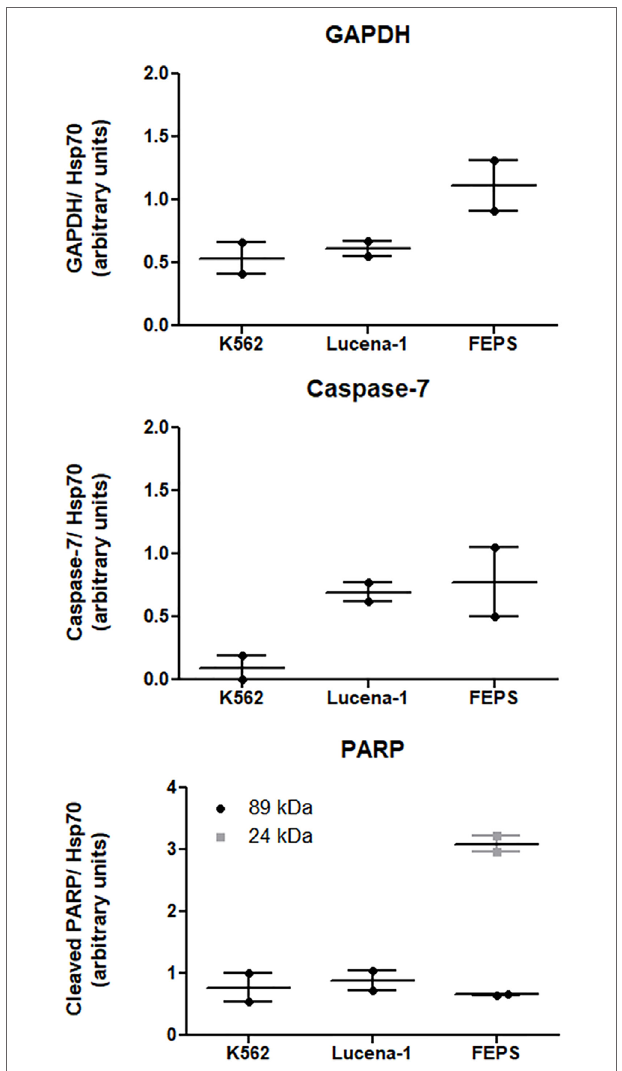
FiGUre 2 | Expression of proteins related to cell death-resistance on K562, Lucena-1, and FEPS cells. Equal amounts of total cellular proteins (100 µg) were loaded in each lane for the detection of glyceraldehyde-3-phosphate dehydrogenase (GAPDH), pro-caspase-7, cleaved PARP, and Hsp70 (loading control) by western blot. Densitometric analysis of each lane was calculated using ImageJ Software. The data are expressed as arbitrary units and represent the mean of two independent